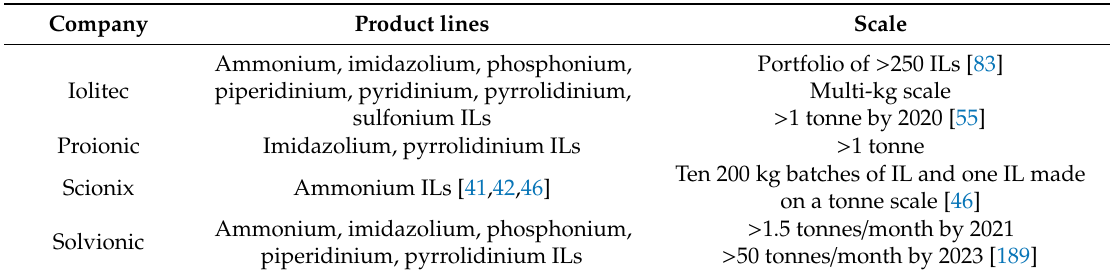
Table 2. Bespoke manufacturers producing ILs on a commercial